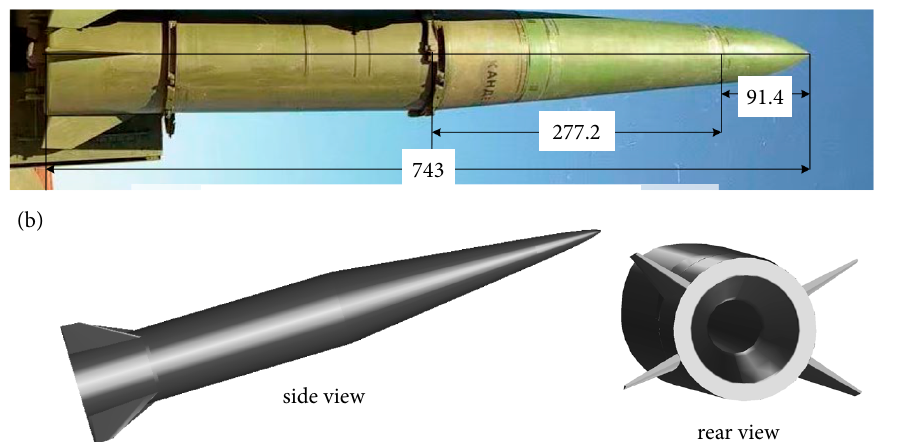
Figure 3. A PRAHV model of Kinzhal-like vehicle. (a) Iskander measured in photoshop (pixels); (b) 3D model of a PRAHV same size with Iskander